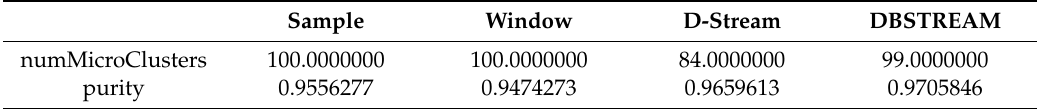
Table 4. Evaluation results of generated data set.